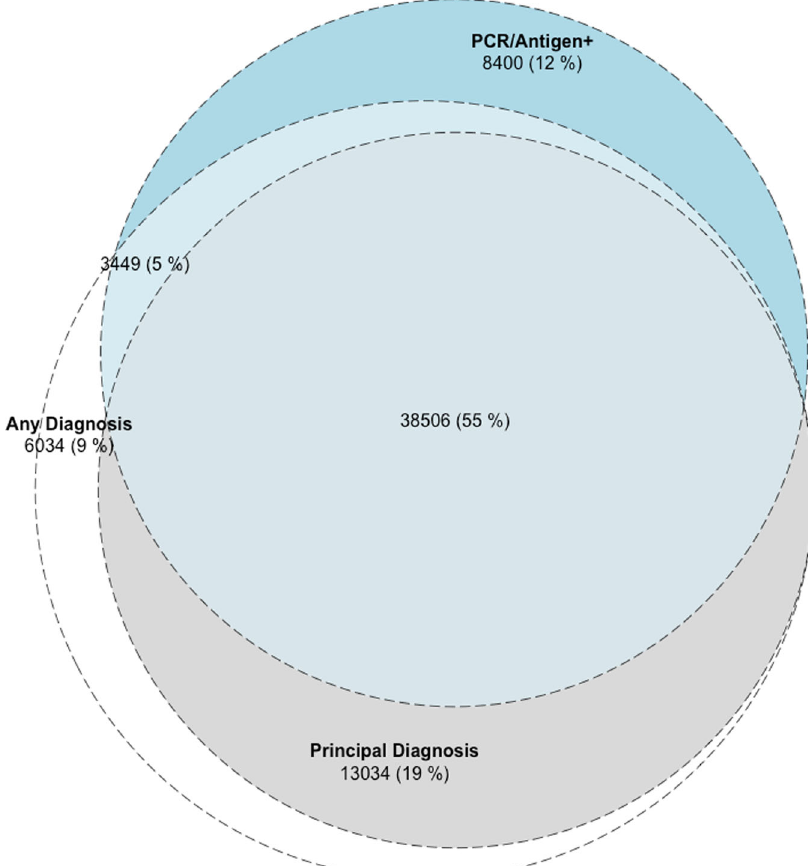
Fig. 2 Overlap of SARS-CoV2 case counts by computational phenotyping strategies. Computable phenotypes for SARS-CoV-2 infection across the study period at Yale New Haven Health System.